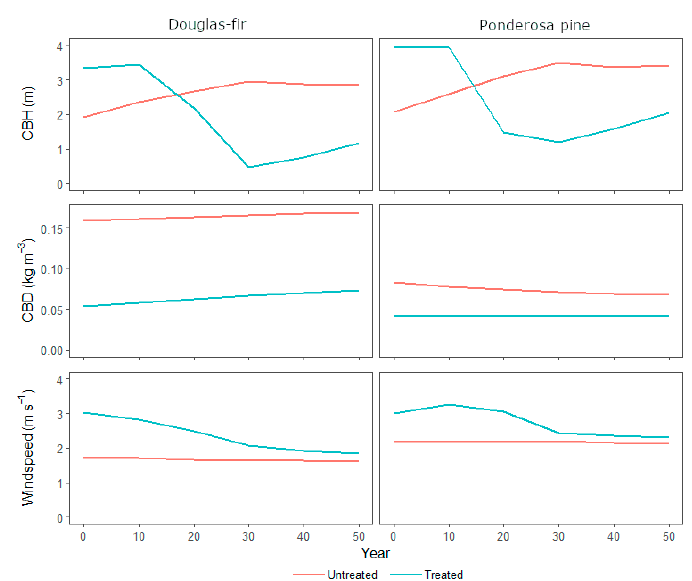
Figure 3. Average CBH (canopy base height), CBD (canopy bulk density) and midflame wind speed over the simulated time periods, by cover type, between treated and untreated stands. The plotted lines are averages of stand-level conditions from across all three scenarios.